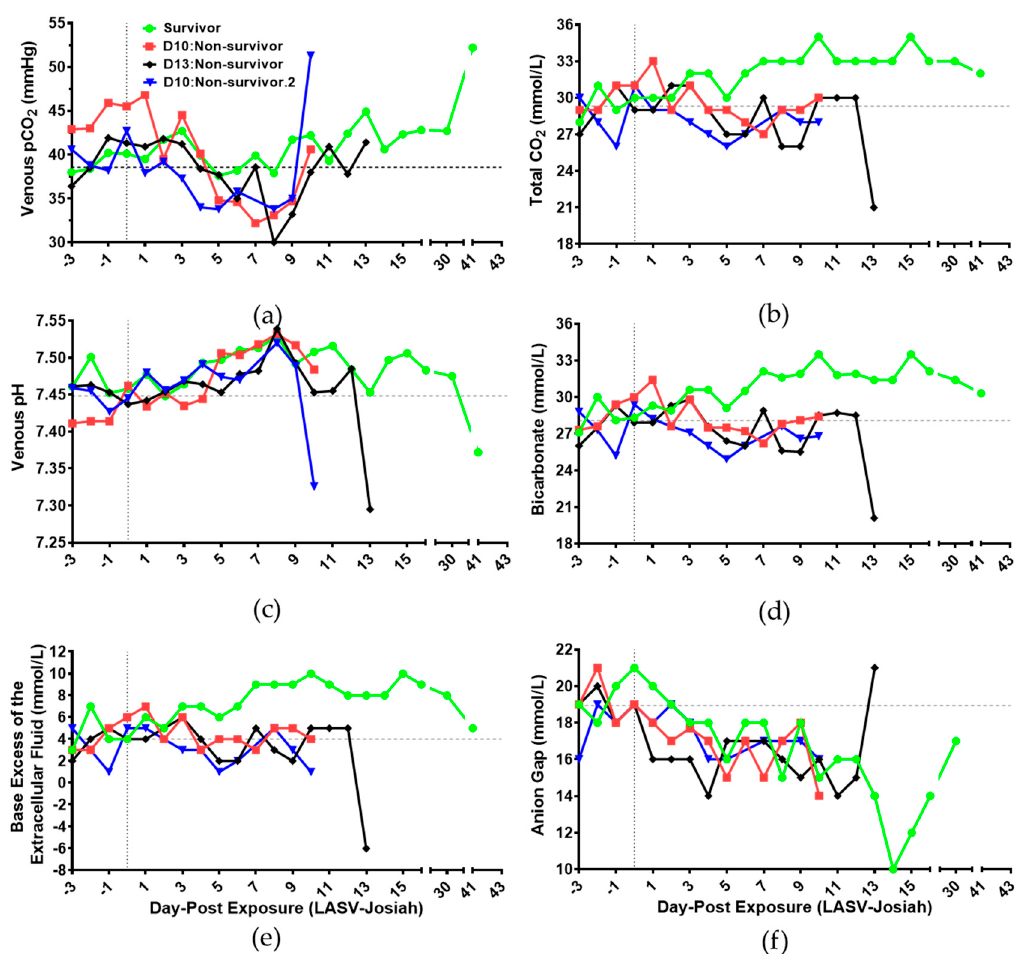
Figure 4. Time course of blood gases and related factors of Lassa virus-challenged cynomolgus macaques. Detection of ( a ) partial pressure of carbon dioxide: pCO 2 , ( b ) total CO 2 , ( c ) pH, ( d ) bicarbonate, and ( e ) base excess of extracellular fluid was determined in whole blood using i-Stat CG4+. Assessment of ( f ) anion gap in plasma involved iStat-1 CHEM8+. ( ● Survivor) ( ■ D10:Non-survivor) ( ♦ D13:Non-survivor) ( ▼ D10:Non-survivor.2) (Vertical grey dotted line: DPE 0) Grey dashed line is average relative to each animal for DPE-3 to DPE 0.